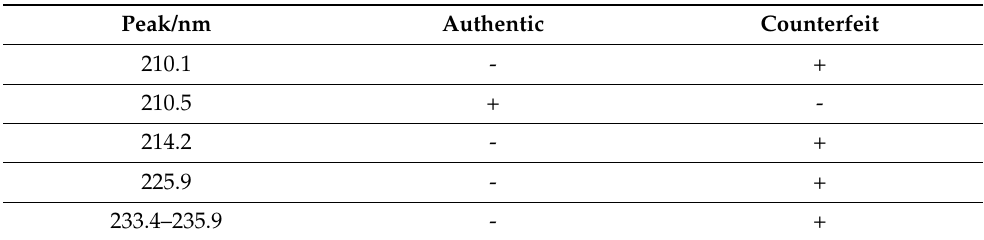
Table 3. List of main peaks which are missing in Zone B of the authentic 100 Euro banknote and present in the counterfeit (and vice